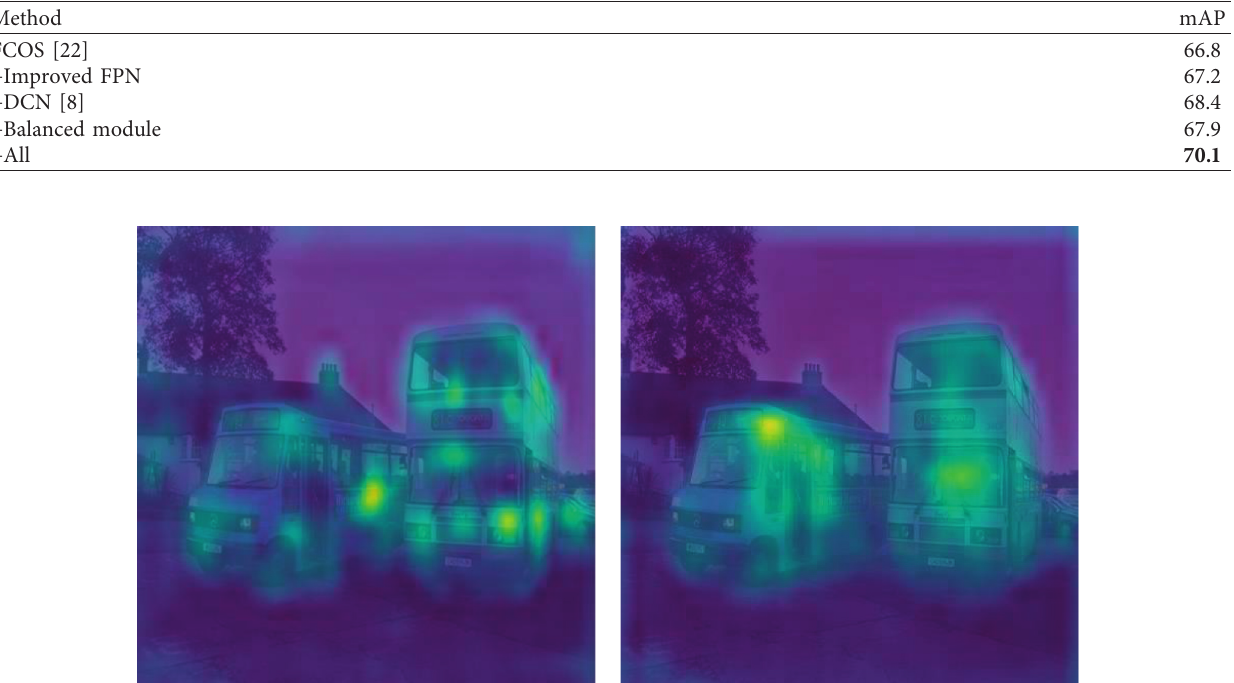
Table 4: Ablation study for the proposed